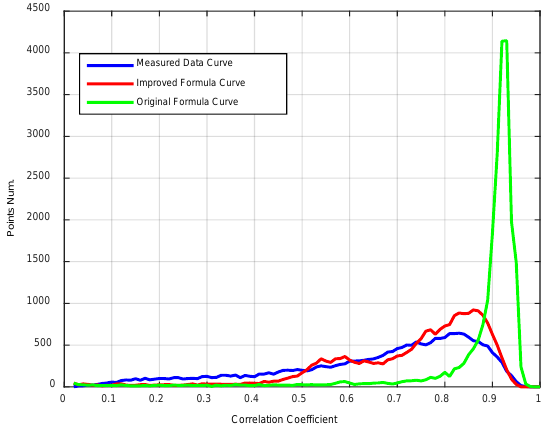
ffi cient distribution obtained by di ff erent Figure 10. Comparison of the correlation coefficient distribution obtained by different methods. Figure 10. Comparison of the correlation coe